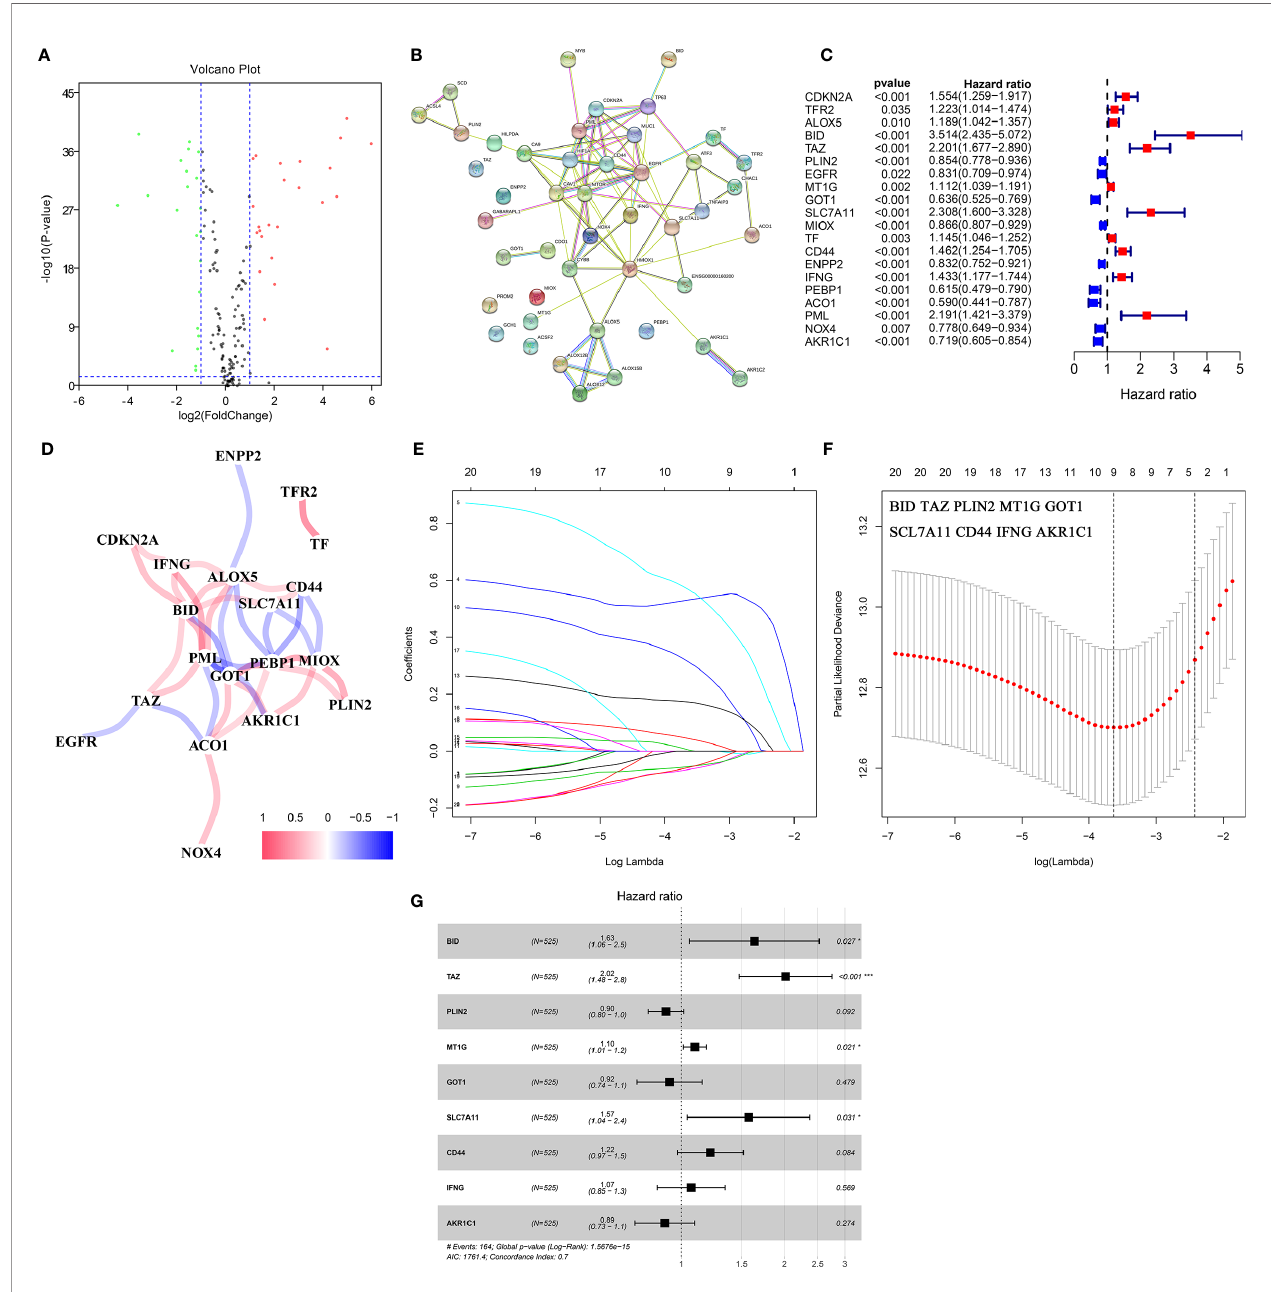
FIGURE 2 | Identi fi cation of key DE-FRGs via Cox regression analysis. (A) The volcano plot of FRGs. (B) The protein – protein interaction between FRGs. (C) Univariate cox regression analysis revealed that a total of twenty DE-FRGs had prognostic value. (D) The correlation network of DE-FRGs. (E, F) Through LASSO Cox regression, nine genes were selected as key DE-FRGs for further analysis. (G) Four genes (BID, TAZ, MT1G, and SCL7A11) were identi fi ed as independent prognostic factors via multivariate Cox regression analysis. DE-FRGs, differentially expressed ferroptosis-related genes; LASSO, least absolute shrinkage and selection operator. ***P < 0.001; *P <